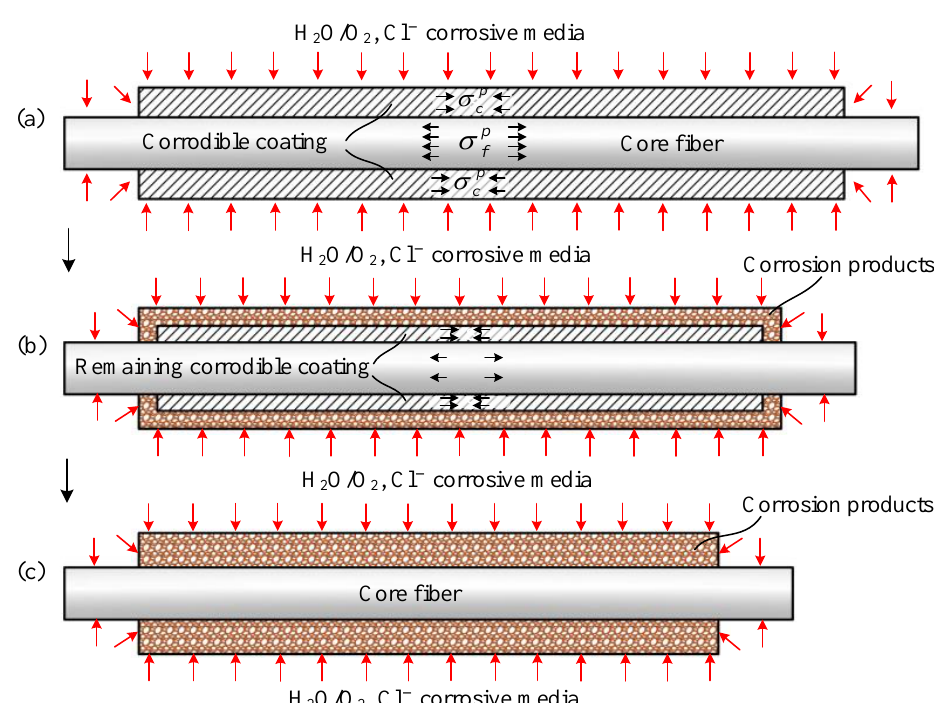
Figure 2. Axial cross-sectional view of the shape recovery mechanism of CIF, ( a ) CIF is in contact with corrosive media, ( b ) the effective force section of the corrodible coating decreases, the equilibrium is broken, and the core fiber shrinks, ( c ) core fiber recovers to the original length after the corrodible coating being corroded thoroughly.